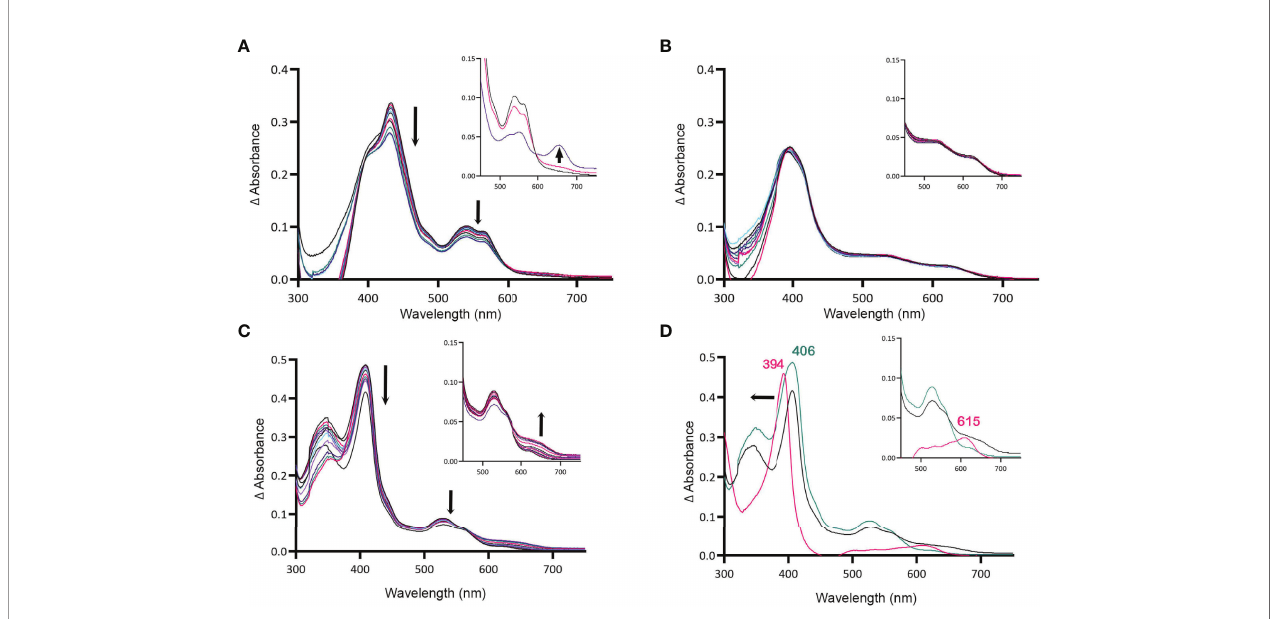
FIGURE 4 | MBP-HupZ degrades heme with the exogenous imidazole group. UV-VIS absorption spectra of 10 m M heme b bound to MBP-HupZ with 1.6 mM imidazole (A) or without (B) incubated with 10 m M ferredoxin, NADPH, an NADPH regeneration system, and catalase. After acidi fi cation of the MBP-HupZ reaction with imidazole, a peak at 660 nm formed ( A, inset, purple). The blank contained 10 m M ferredoxin, NADPH, an NADPH regeneration system, and catalase, with or without 1.6 mM imidazole. MBP-HupZ (10 m M) in solution with 10 m M MP11, 10 m M ferredoxin, NADPH, an NADPH regeneration system, and catalase (C) . (D) The zero minute of the MP11 (teal) and the 6-h time point (black). After acidi fi cation of the reaction (pink), the Soret shifted from 406 to 394 nm, and a peak formed at 626 nm ( D , inset, pink). The blank contained 10 m M ferredoxin, an NADPH regeneration system, and catalase, with or without 1.6 mM